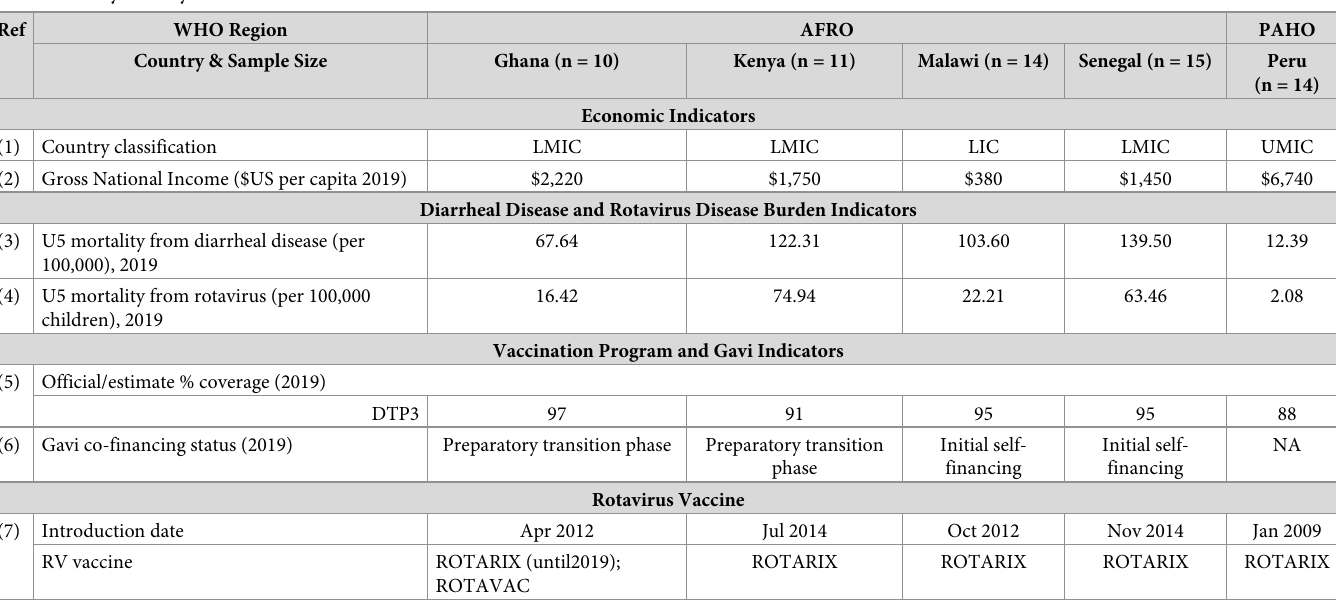
Table 1. Study country characteristics. Ref